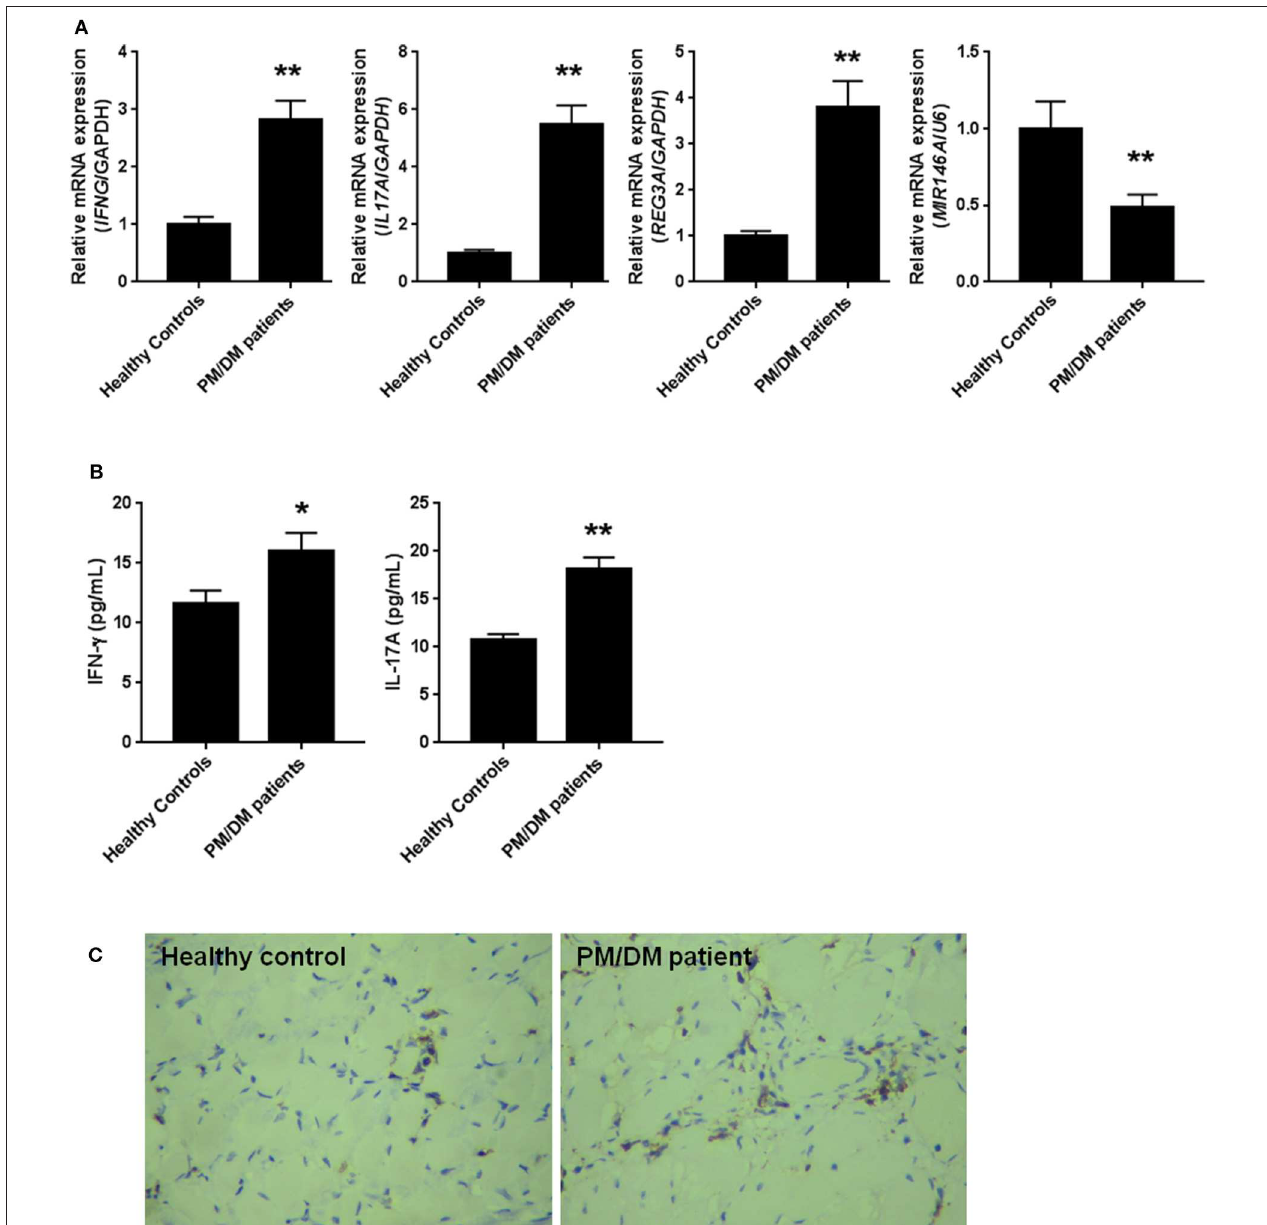
FIGURE 1 | The levels of regenerating islet-derived protein 3-alpha (REG3A) was increased and miR-146a was decreased in polymyositis and dermatomyositis (PM/DM) patients. (A) Peripheral blood mononuclear cells (PBMCs) were isolated from patients ( n = 25) and the healthy controls ( n = 20) and the messenger RNA (mRNA) levels of interferon gamma (IFN- γ ), interleukin (IL)-17A, REG3A, and miRNA-146a were determined by real-time PCR. The relative mRNA expression was normalized using glyceraldehyde 3-phosphate dehydrogenase (GAPDH)/U6. (B) The levels of IFN- γ and IL-17A in serum from patients and the healthy controls were determined by ELISA assay. (C) The REG3A levels from patients and the healthy controls were determined by immunohistochemistry. Data are shown as means ± SEM. * p < 0.05, ** p < 0.01 in comparison with the healthy controls. PBMCs were obtained from 20 healthy controls and 25 patients with